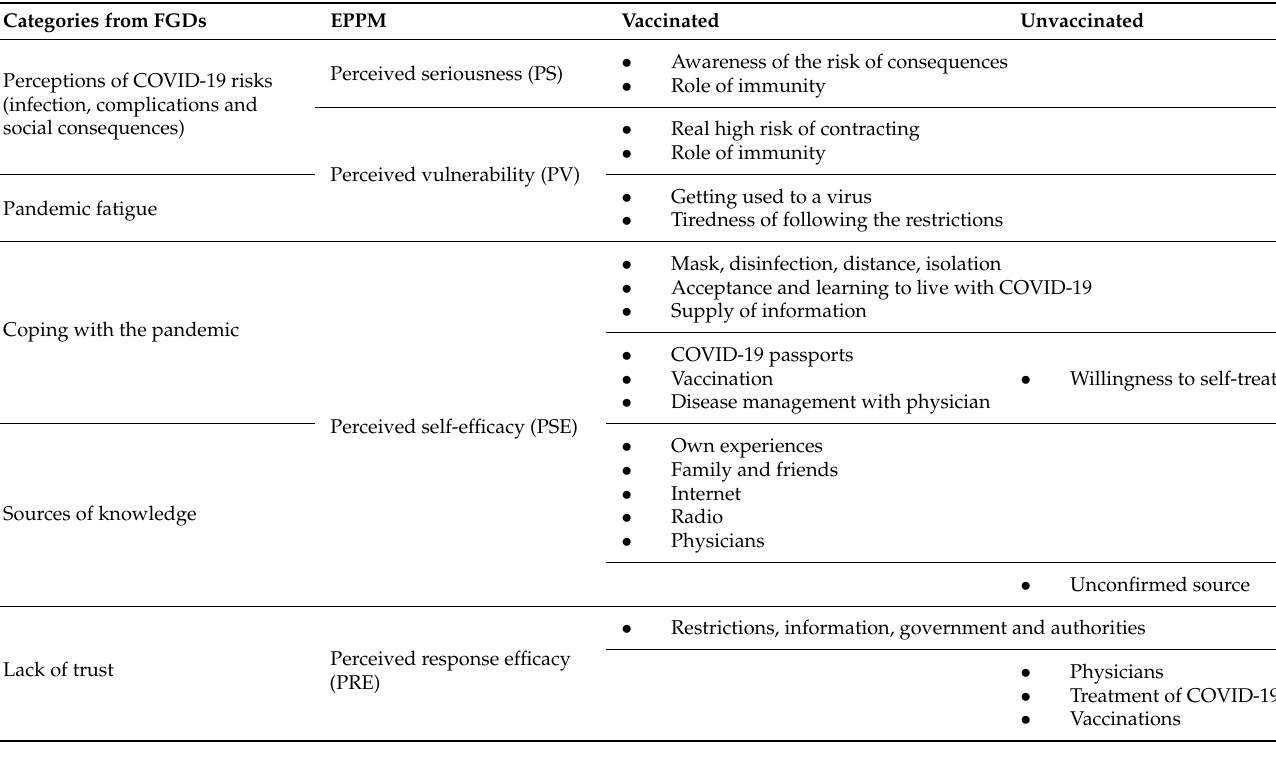
Table 3. The crosswalk between emergent categories and constructs the EPPM by vaccinated and unvaccinated